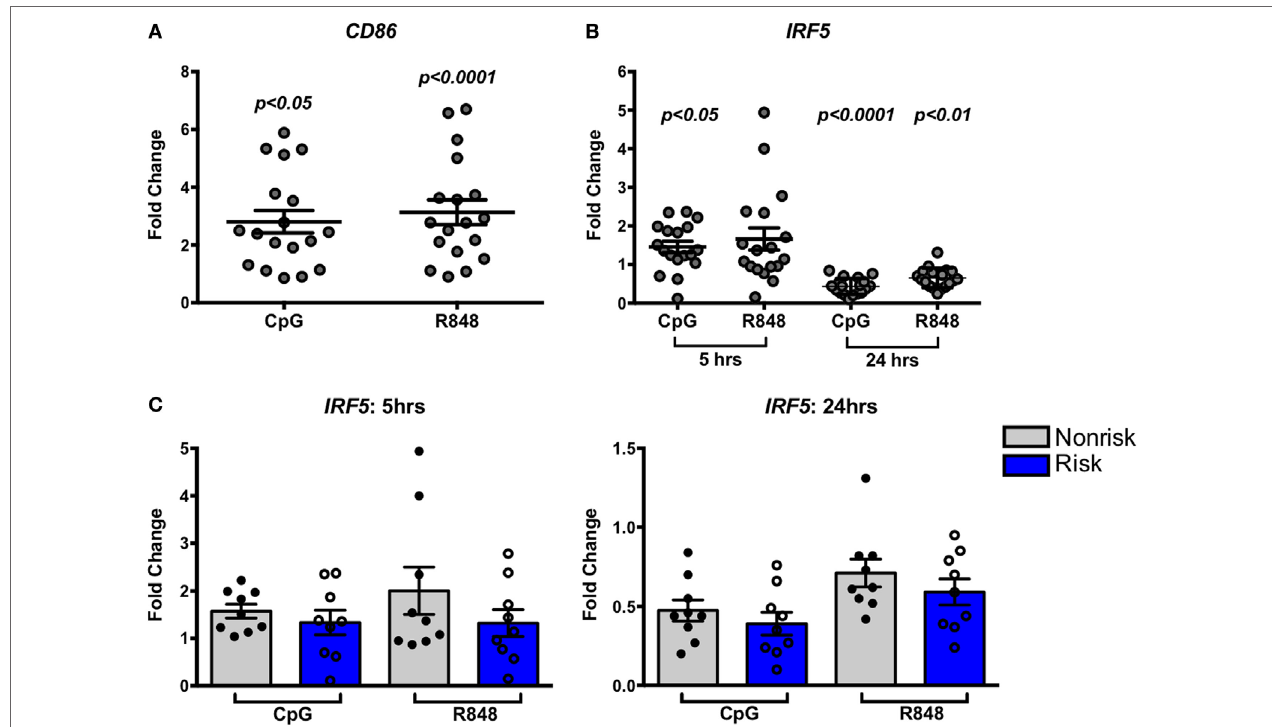
FigUre 3 | Interferon regulatory factor 5 (IRF5) risk alleles do not affect induced IRF5 expression in B cells. Purified B cells were stimulated with toll-like receptor agonists CpG or R848 for the indicated times and subjected to qPCR for CD86 (a) or IRF5 (B,c) IRF5 qPCR. Results are shown combined (B) and separated by haplotype (c) . Unstimulated cell expression values are normalized to 1.0. p < 0.05, p < 0.01, and p < 0.0001 by Friedman test with Dunn’s multiple comparisons test (a,B) , p = ns by Wilcoxon matched-pairs signed rank test for each treatment (c)